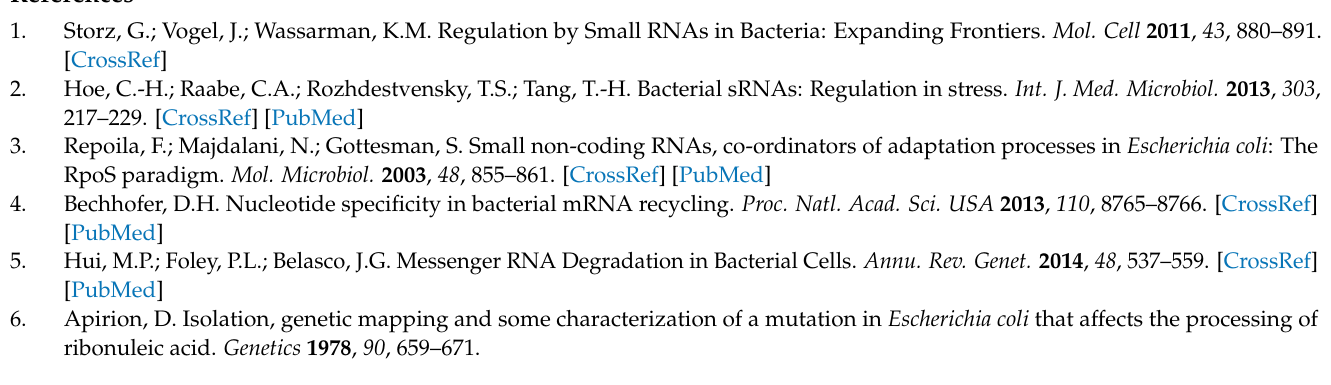
Table S2: Bacterial strains and plasmids used in this study; Table S3: Primers used in this